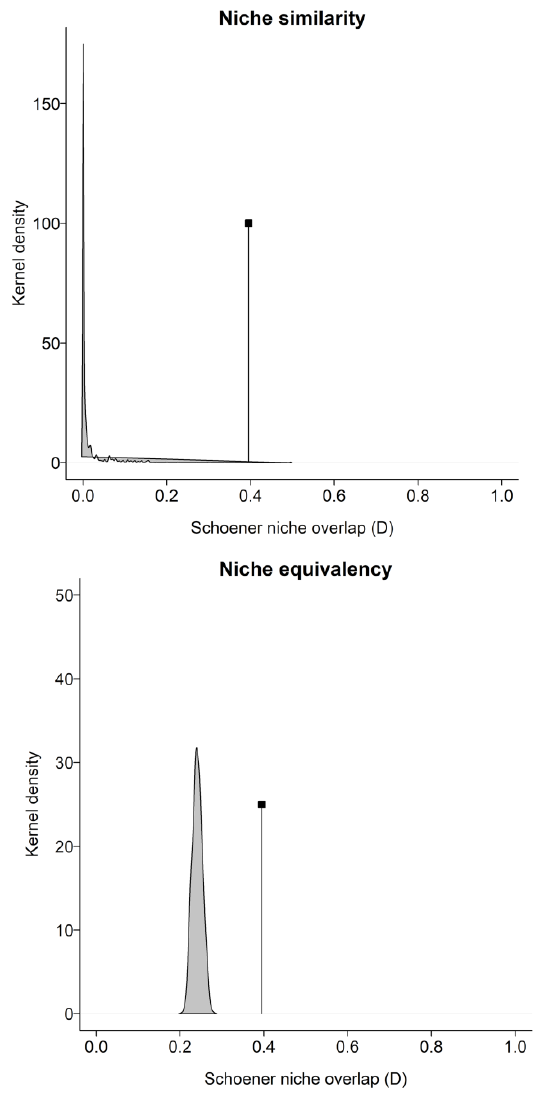
Fig 2 . Niche similarity test and niche equivalency test comparing Apis mellifera Linnaeus, 1758 climatic niche overlap between its native and exotic ranges using 1000 randomizations of the exotic range. In the niche similarity, only the native range was randomized while in the niche equivalency test both ranges are randomized.